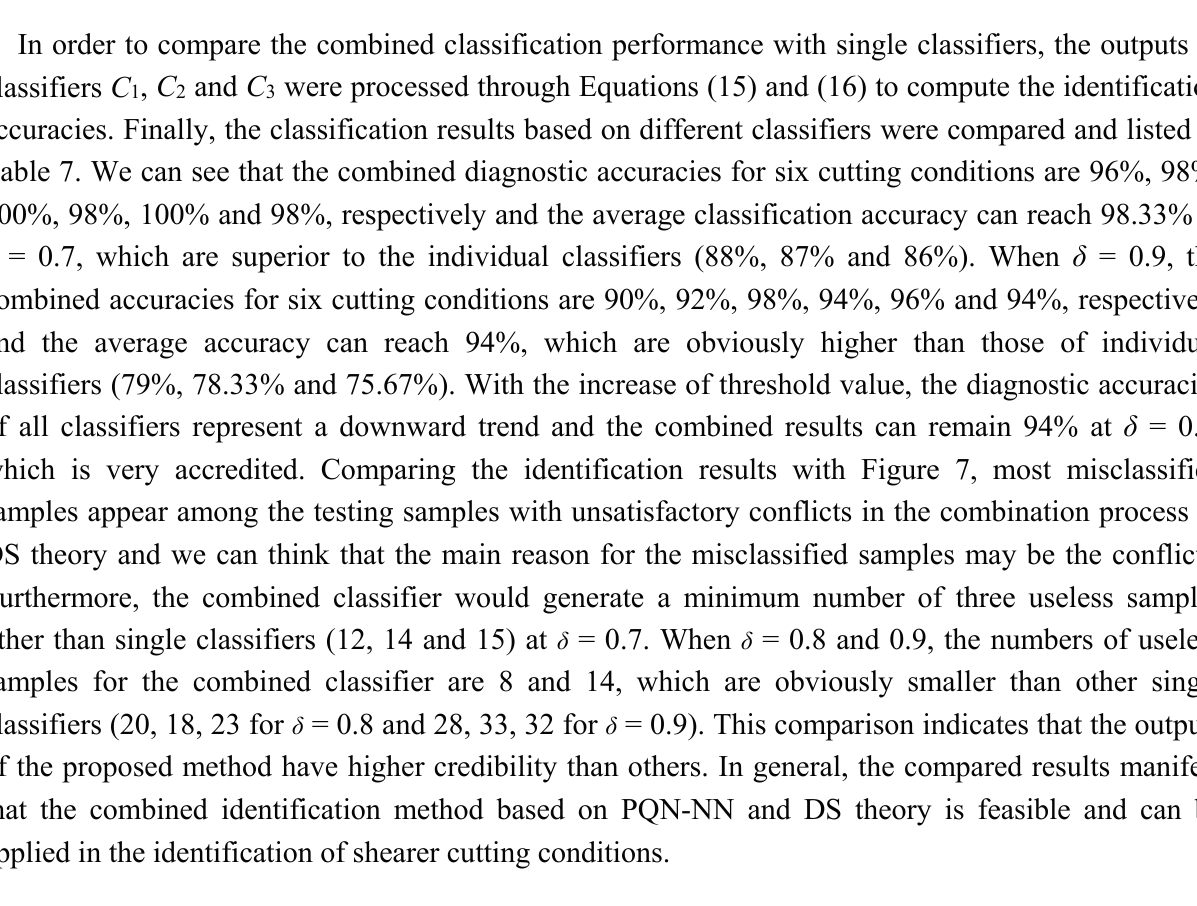
Figure 9. Classification results based on combined classifier at δ =